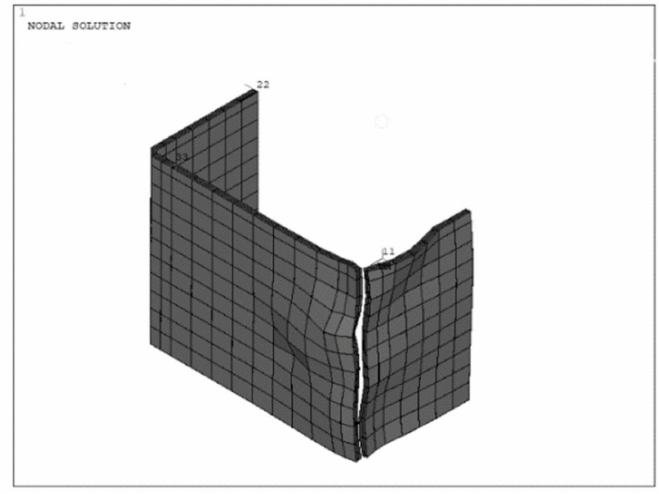
Figure 8. Fracture of TRM jacket in model